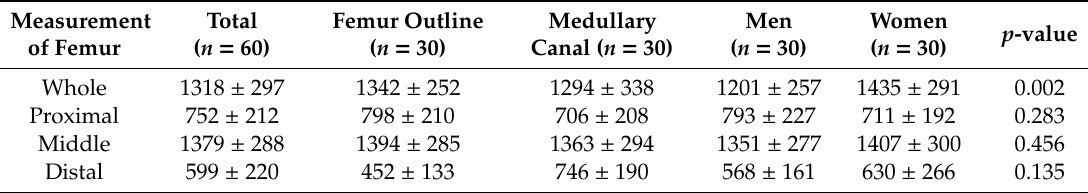
Table 2. Radii of di ff erent parts in di ff erent